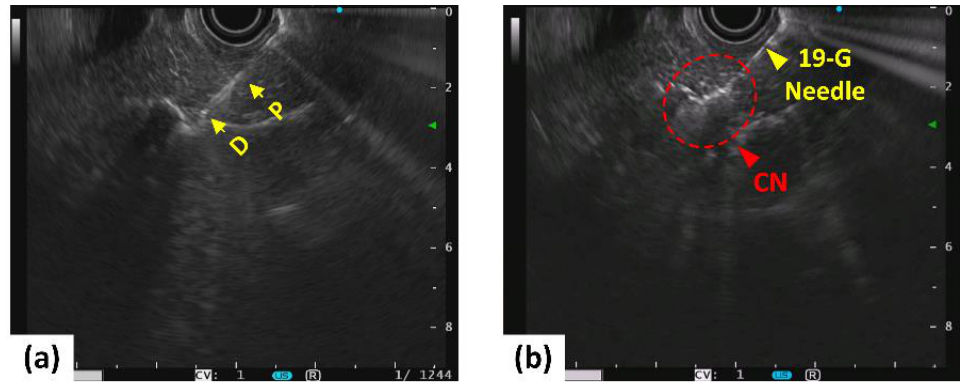
Figure 2. EUS-guided LA on pancreatic tissue in porcine models before (left; a ) and after (right; b ) irradiation at 5 W for 160 s (P = proximal and D = distal ends of diffusing applicator; CN: coagulative necrosis).